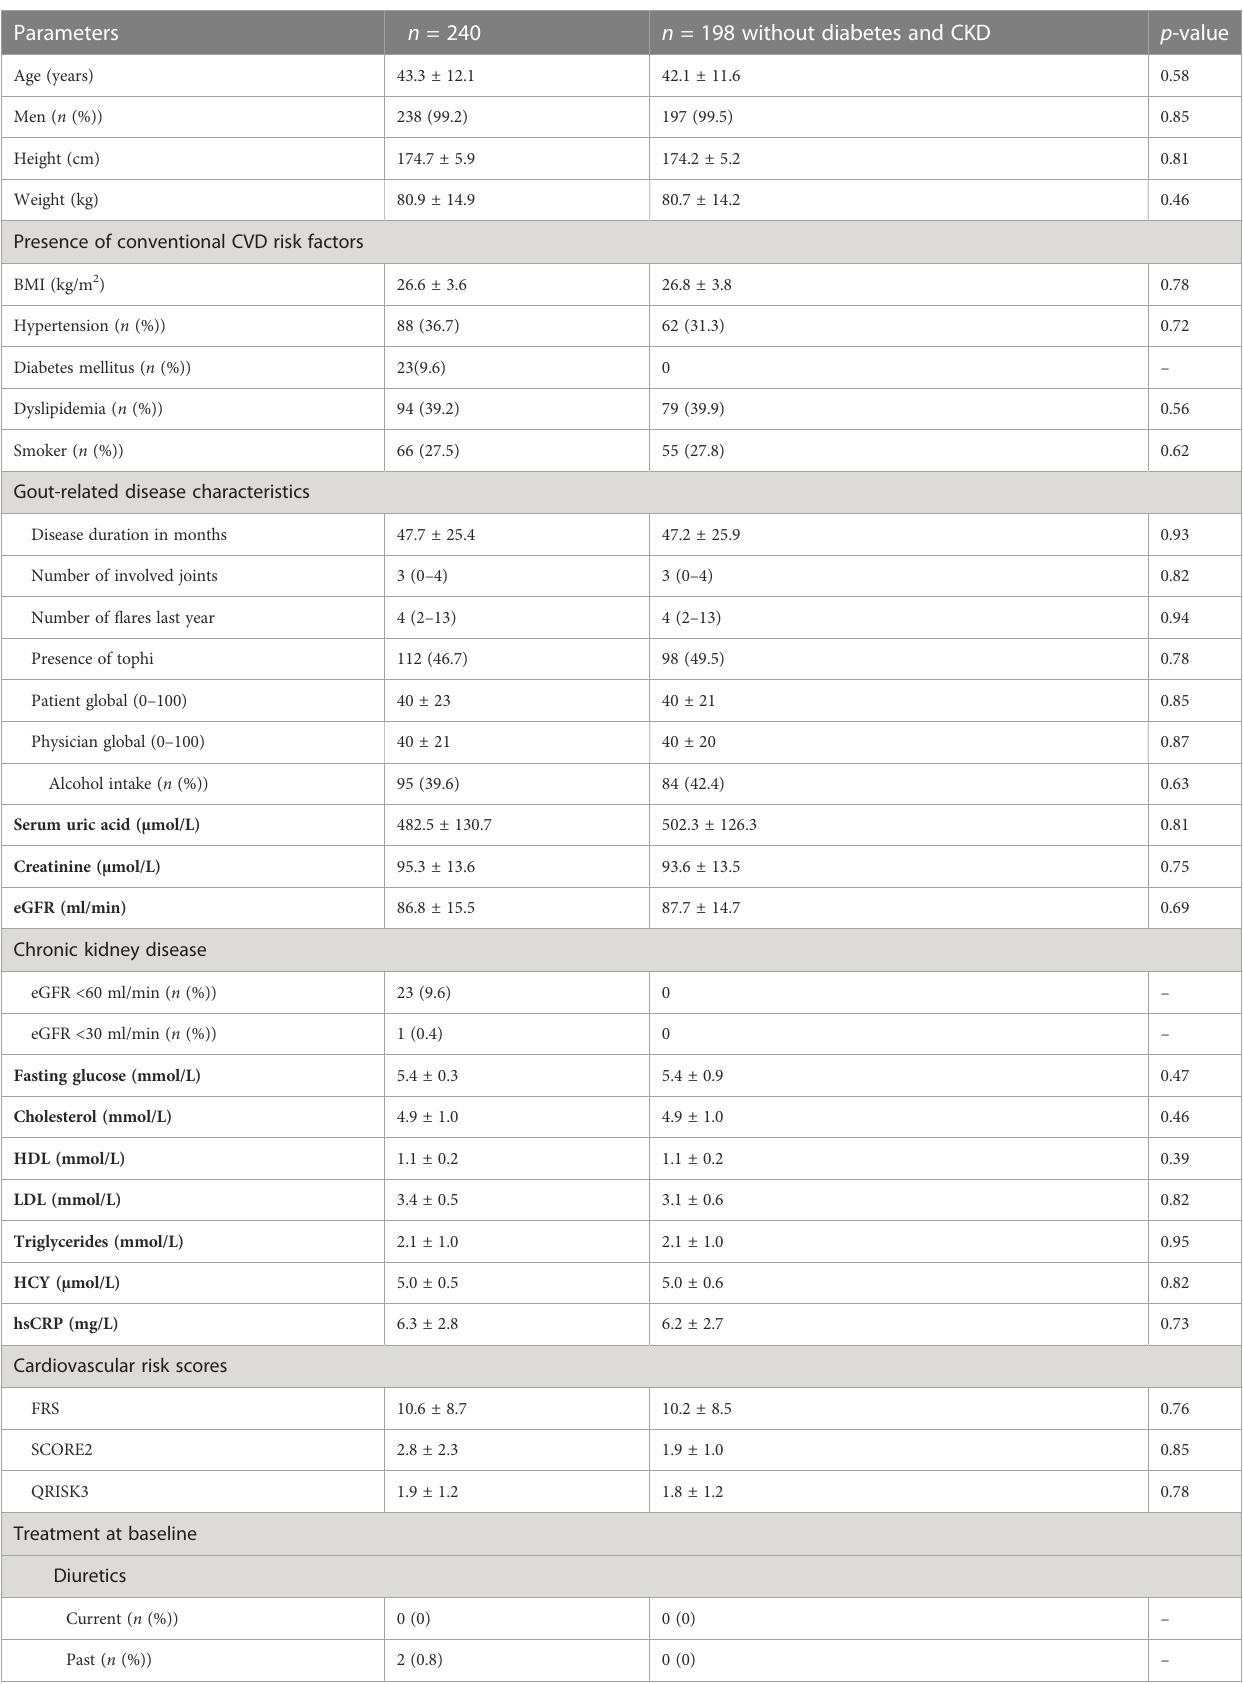
TABLE 1 Baseline characteristics of the entire cohort in patients with both carotid and bilateral foot and ankle ultrasound